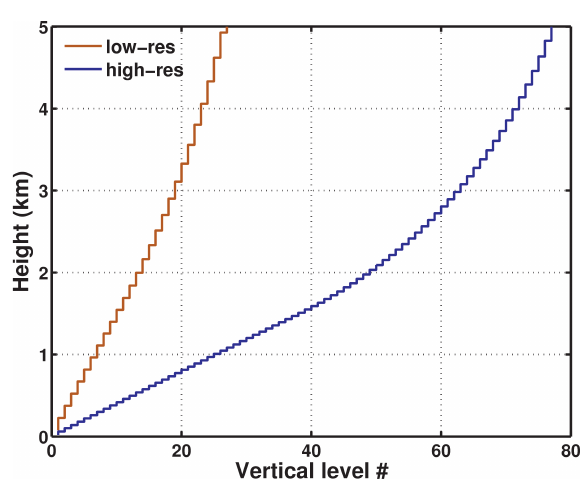
Fig. A1. Vertical distribution of grid levels for the GFDL SCM- CLUBB using the multi-variate probability density functions with dynamics (MVD PDFs) at lower (brown) and higher (blue) resolu-